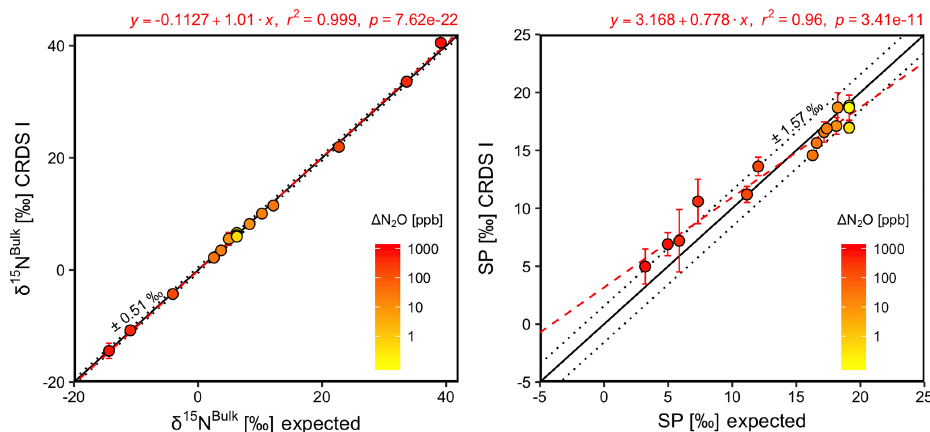
Figure 10. Correlation diagrams for δ 15 N bulk and SP measurements at various (cid:49) N 2 O mole fractions analyzed by CRDS I plotted against expected values. The remaining plots for [ N 2 O ] , δ 15 N α , δ 15 N β and δ 18 O are provided in Sect. S4 (Fig. S4-11). The solid black line denotes the 1 : 1 line, while the dotted line indicates ± 1 σ of the residuals from the 1 : 1 line. The dashed red line represents a linear fit to the data. Individual equations, coefficients of determination ( r 2 ) and p values are indicated above each plot. Each data point represents the mean and standard deviation (1 σ ) of triplicate measurements. The inset plots indicate the standard deviation (1 σ ) of the triplicate measurements achieved at different (cid:49) N 2 O mole fractions, and the 1 : 1 line is similarly a solid